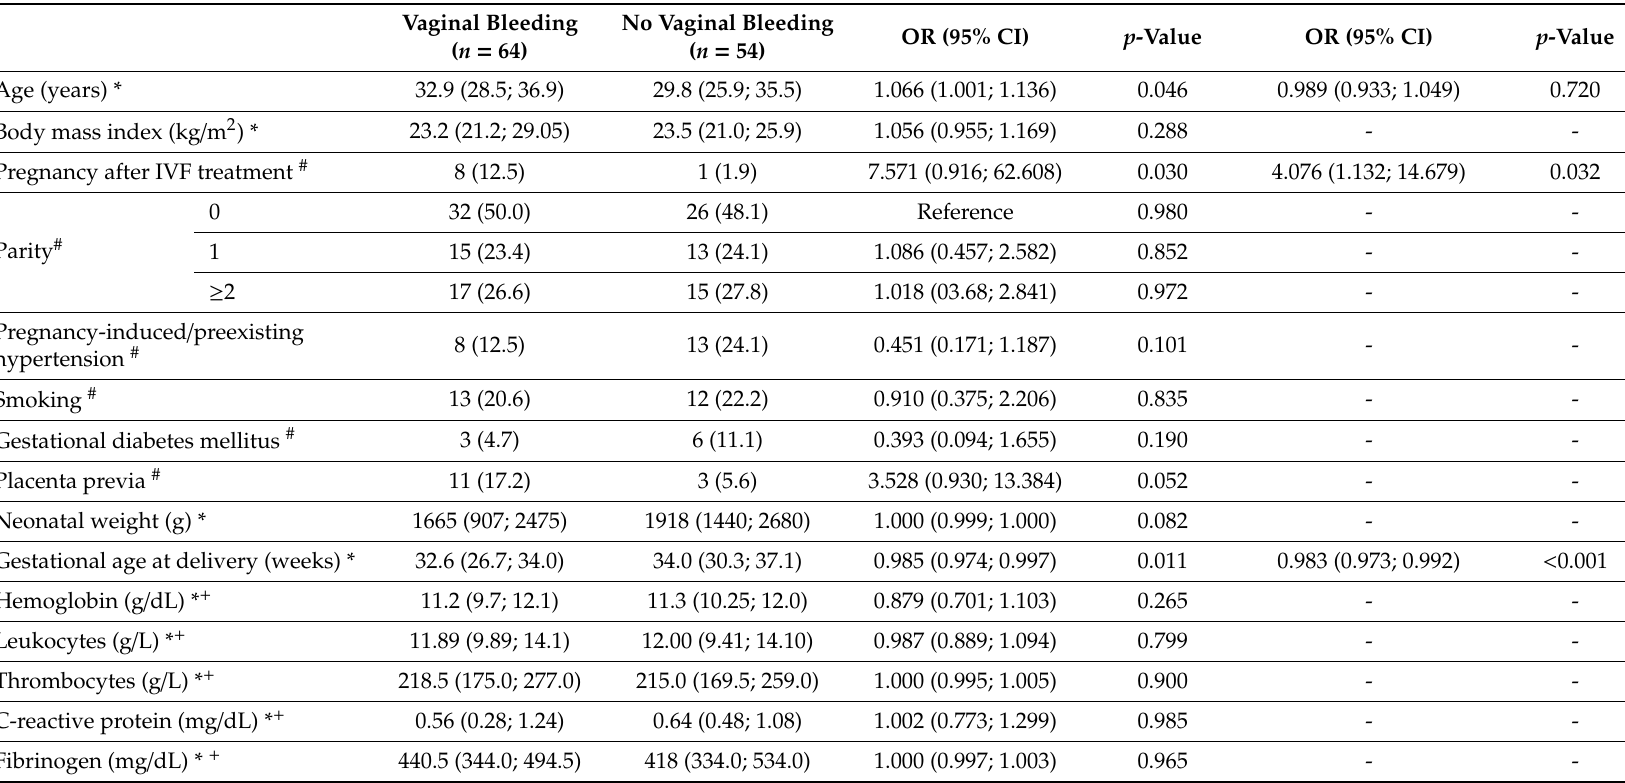
Data are provided as * median and interquartile ranges or # numbers and frequencies; italic letters indicate statistical significance. + Laboratory parameters within 48 h before delivery. OR: Odds Ratio, IVF: in vitro